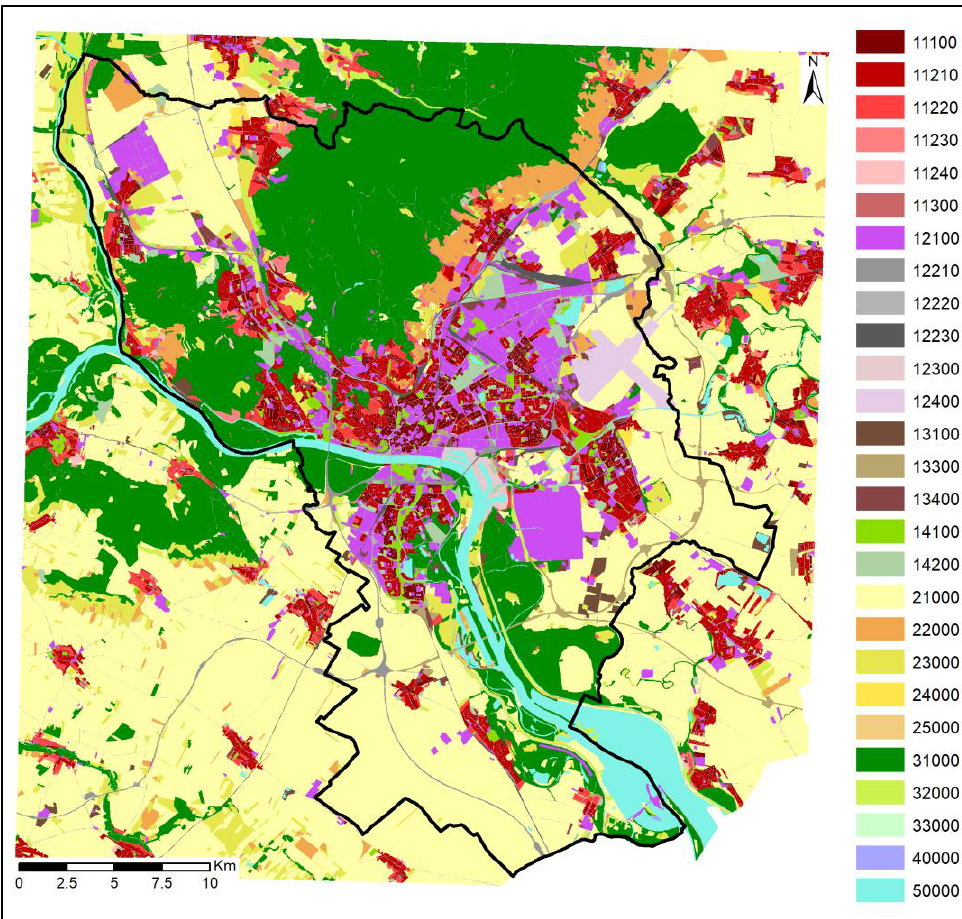
Figure 2. The land cover of Bratislava and its surroundings by Urban Atlas classes.